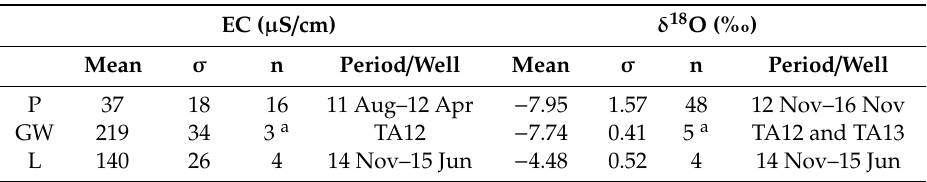
Table 1. End-member concentrations for electrical conductivity (EC) and δ 18 O (mean) and uncertainty ( σ , standard deviation) for precipitation (P), groundwater (GW), and lake water (L). The number of data points (n) and periods (P / L) or wells (GW) are indicated. a depths greater than 6 m in TA12 and TA13. The period of observation is given as month /